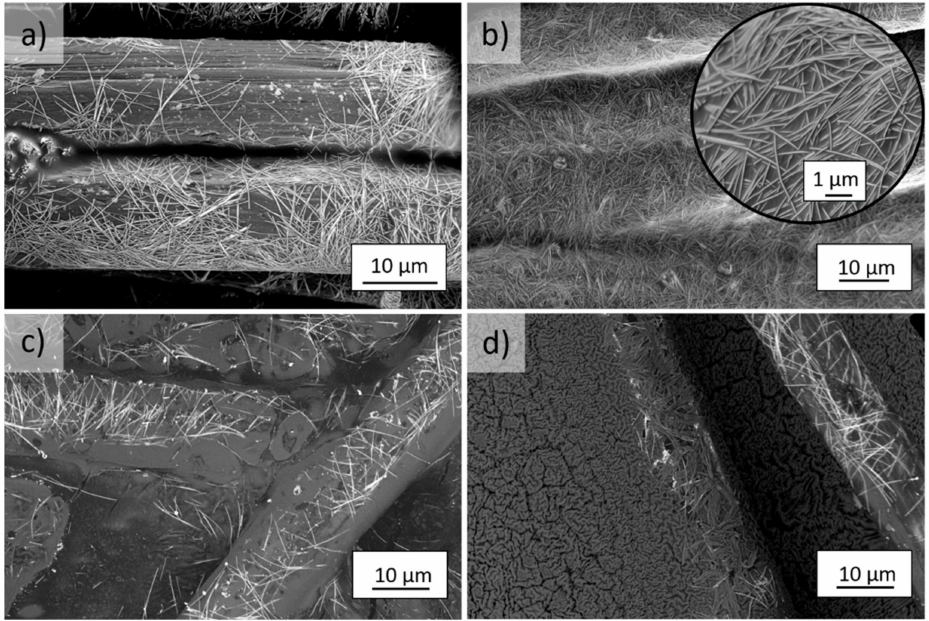
Figure 5. SEM images of modified m Ar fibers after the ( a ) 1-fold and ( b ) 5-fold application of AgNWs and the ( c ) mixture Ag+S, and ( d ) layer-by-layer Ag/S modification (magnification of 2500 × and 20,000 ×